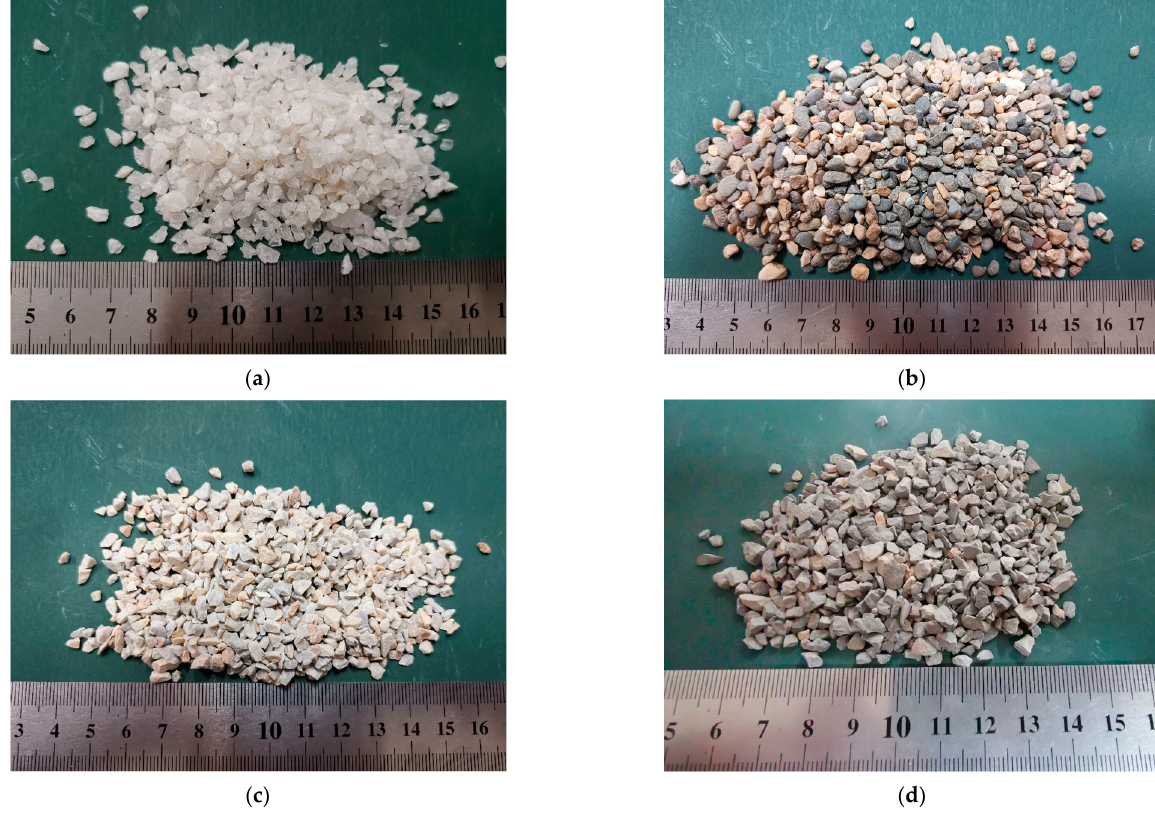
Figure 1. Particle morphologies (2.5–5.0 mm) for ( a ) quartz sand, ( b ) river sand, ( c ) manufactured sand-A, and ( d ) manufactured